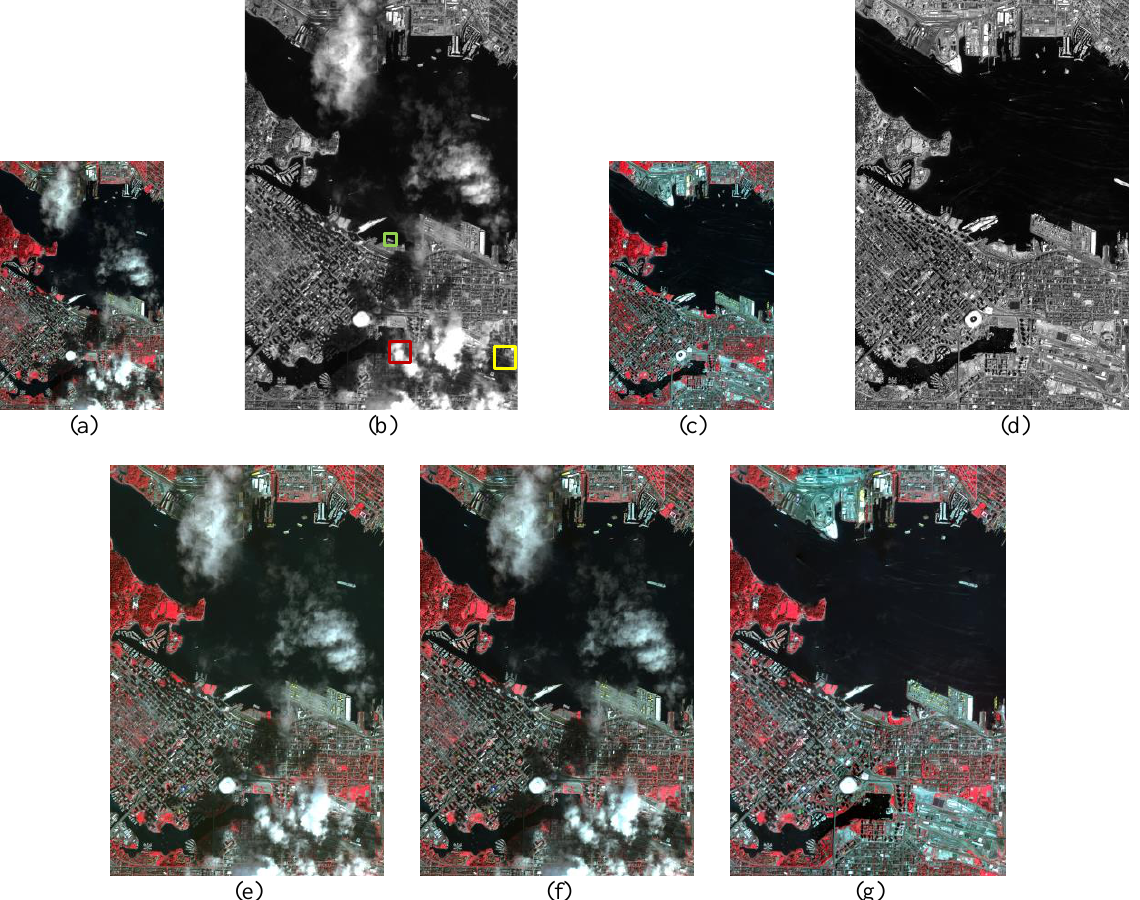
Figure 3. Experimental datasets and results. (a) Target MS image with clouds and cloud shadows on March, 31, 2015. (b) Target PAN image with clouds and cloud shadows on March, 31, 2015. (c) Auxiliary MS image on May 30, 2015. (d) Auxiliary PAN image on May 30, 2015. (e) PCA fusion result. (f) GS fusion result. (g) The fusion result of the proposed integrated framework. corresponding HR PAN images, and B represents the number of spectral